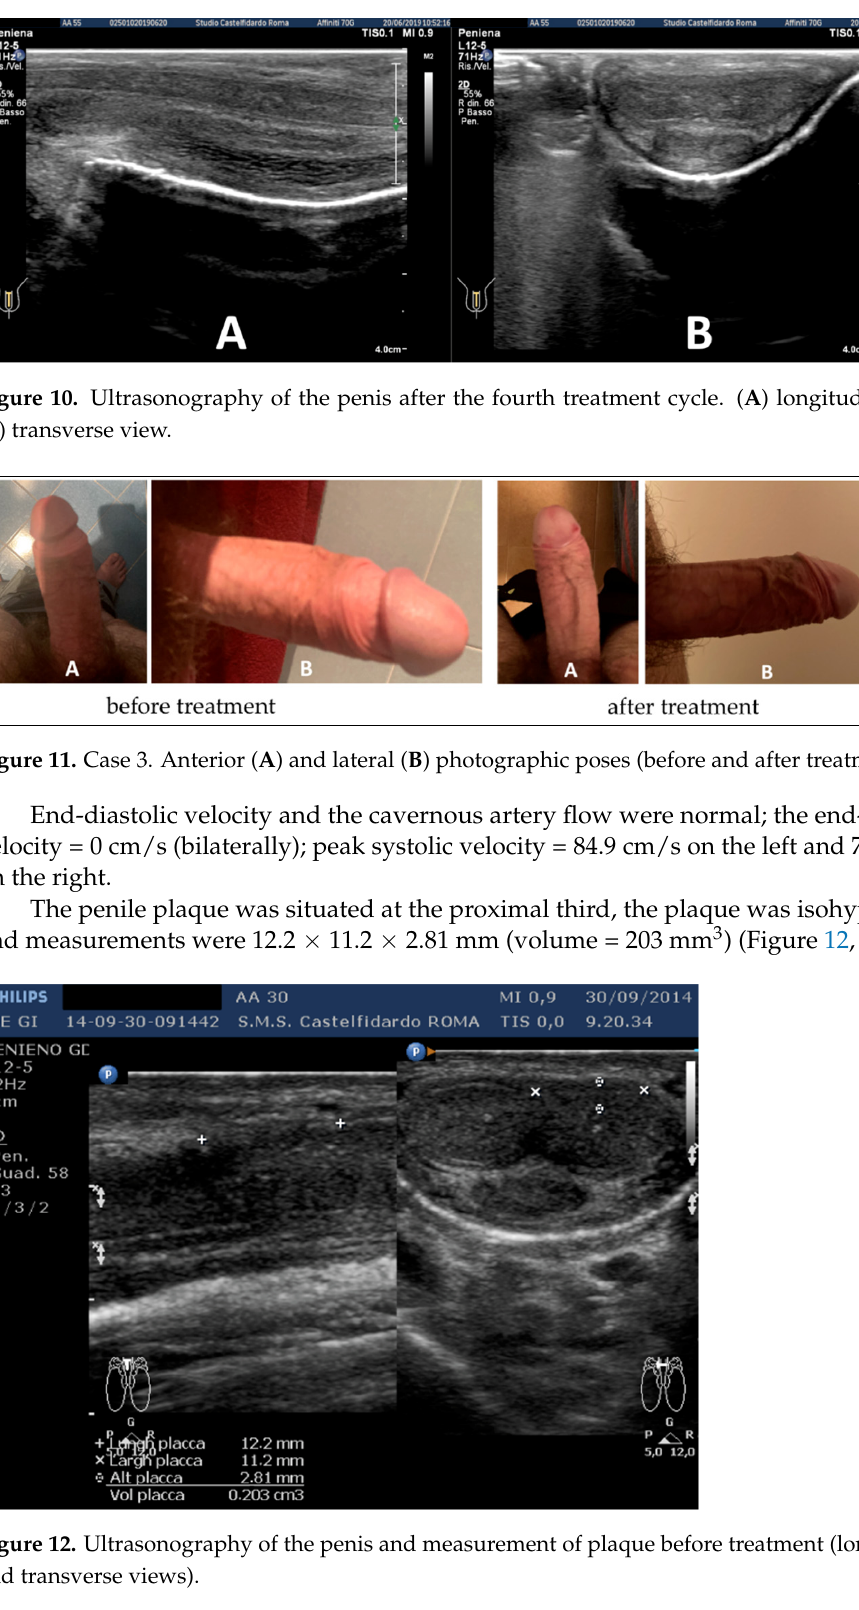
Figure 12. Ultrasonography of the penis and measurement of plaque before treatment (longitudinal and transverse views).